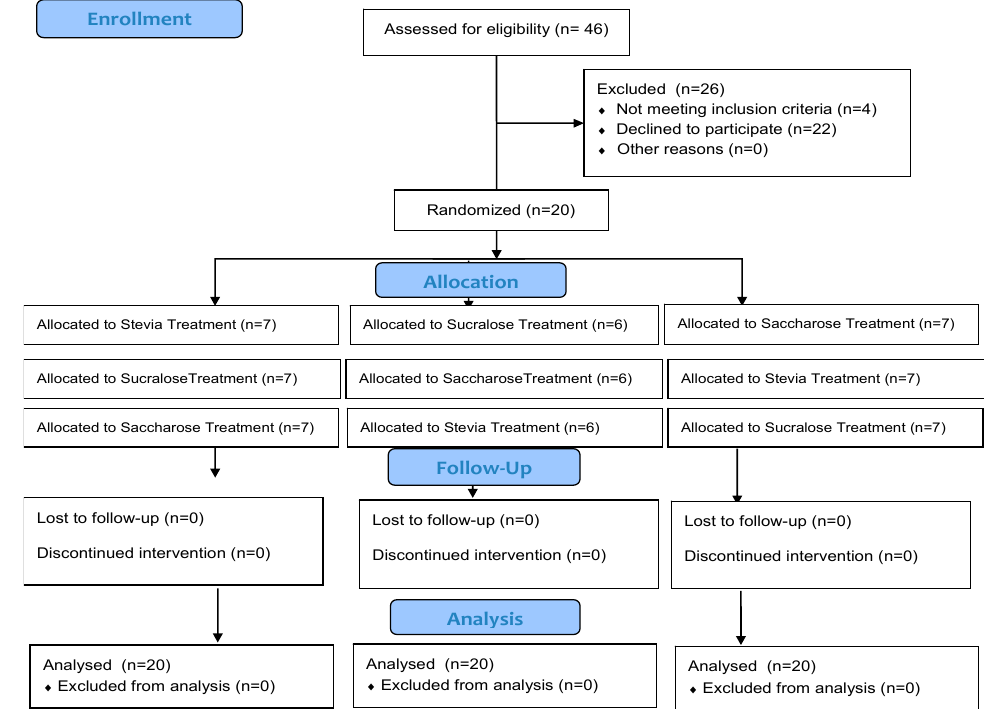
Figure 3. Consort flow diagram of the study.